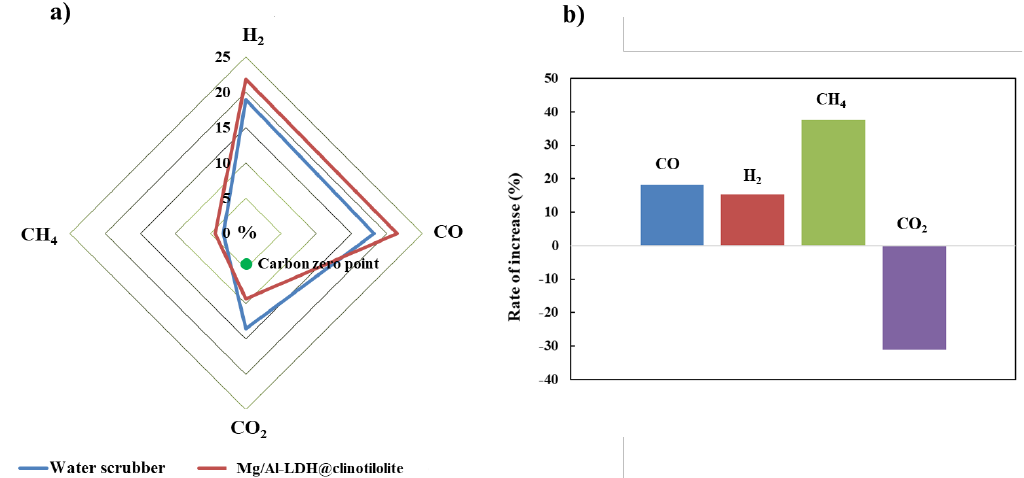
Figure 4. Change in content of H 2 , CO, CH 4 , and CO 2 in syngas for which tar removal was performed by passing through the water scrubber and Mg/Al-LDH@clinoptilolite column ( a ): composition ratio %, ( b ): rate of change %.